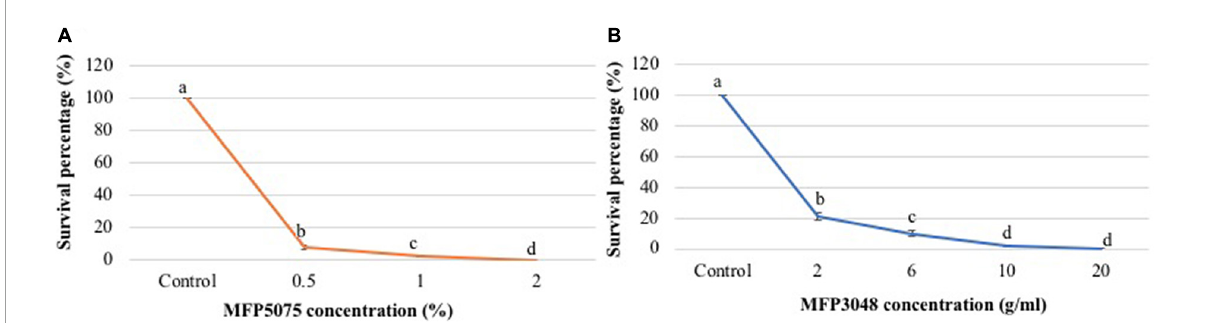
dissolved in PRD. After 4 weeks of treatment (243.3 ±